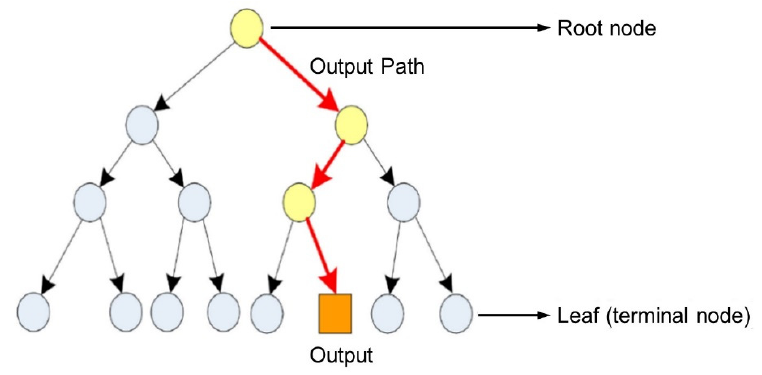
Figure 3. Conceptual diagram of a decision tree (DT).